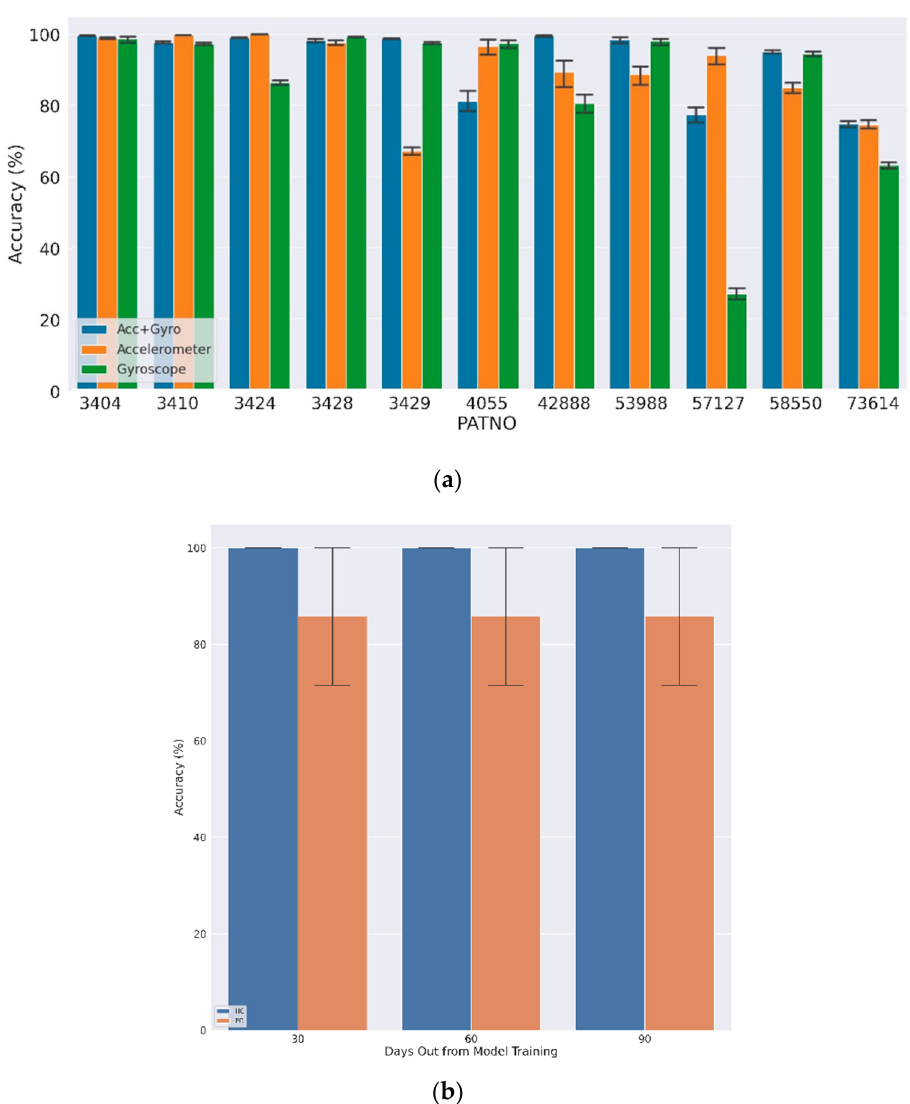
Figure 5. Daily average PD classification results: ( a ) average daily LOGO CV accuracy for first 10 days of sensor data; ( b ) average 5-day accuracy for data after 1, 2, and 3 months. Table 2. Comparison of model performance with other machine learning